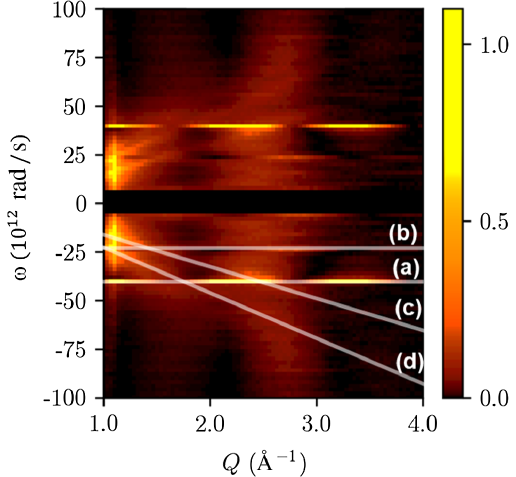
˜ S 0 ð Q; ω Þj 2 . The low- FIG. 7. The power spectrum P 0 ð Q; ω Þ ¼ j frequency part of the plot ( ω < 5 × 10 12 rad = s) is darkened to help enhance the contrast. Nonlinear processes shown in Fig. 1 appear as straight lines when the data are displayed in this way. These excitations are identified in the lower half-plane of the figure. (a) Impulsive simulated Raman scattering. (b) Spontane- ous hyper-Raman scattering. (c),(d)